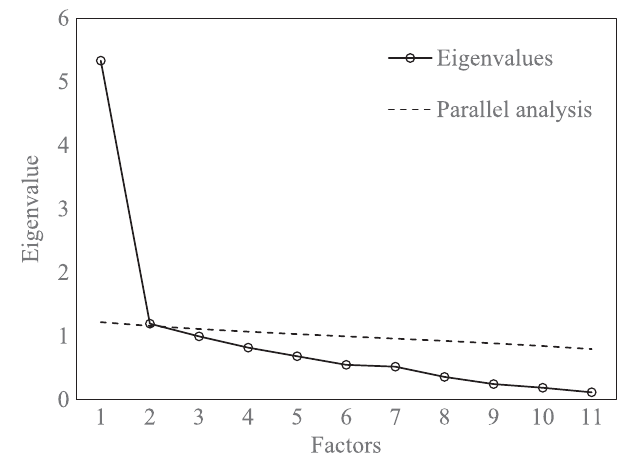
FIG. 6. Scree plot for EFA of Chinese students ’ post-test with parallel